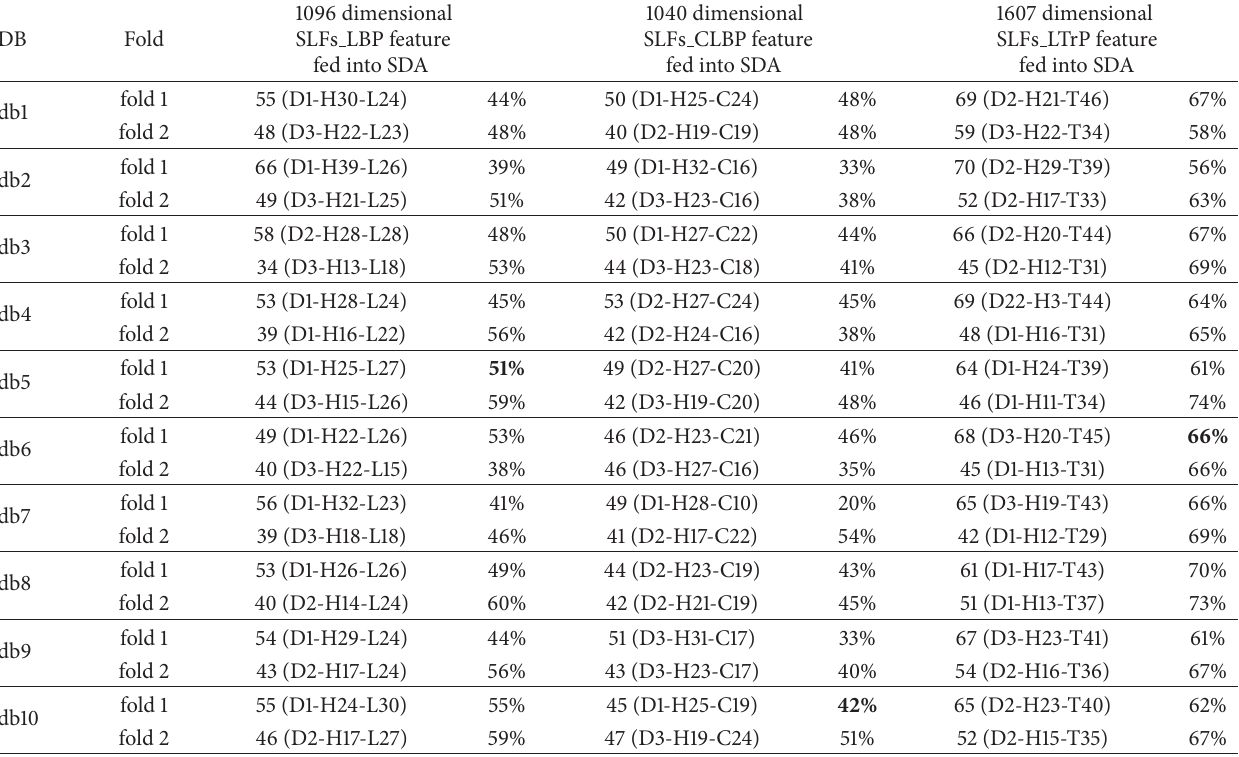
Table 1: Comparison SDA results derived from the combination of different local pattern features and global